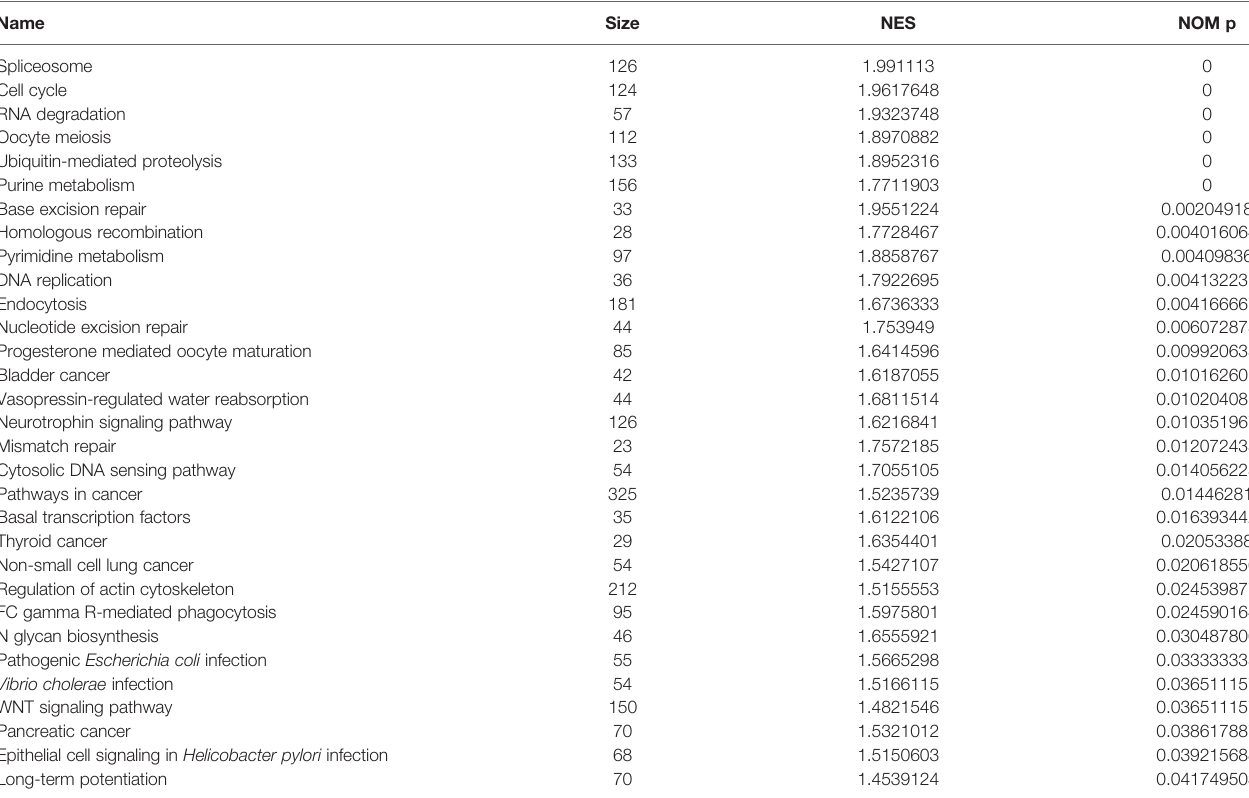
TABLE 5 | Signaling mechanisms of high-risk